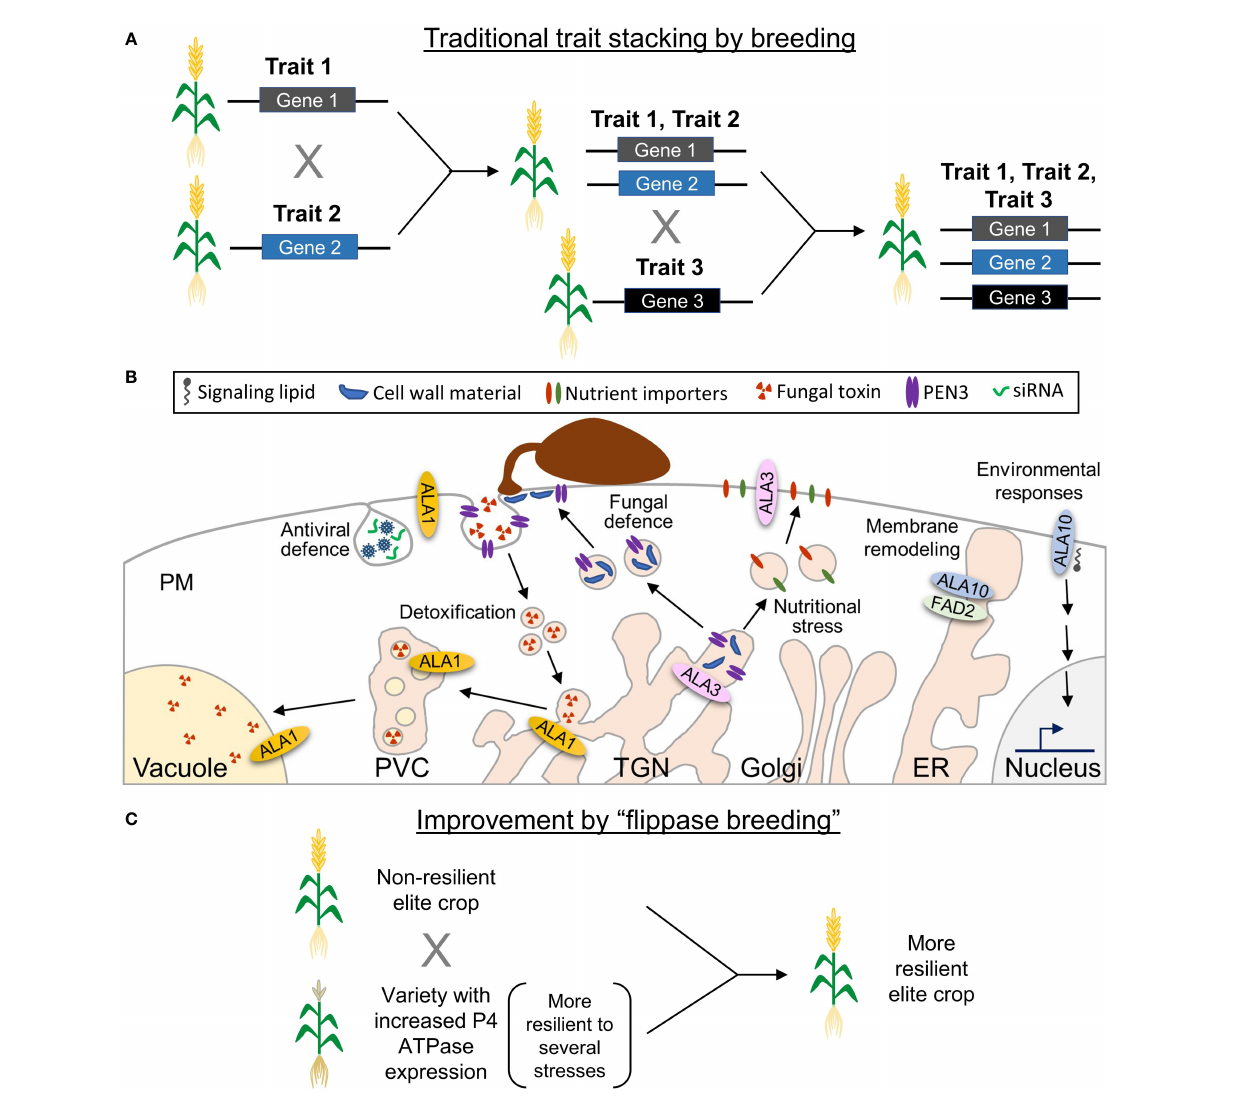
FIGURE 1 Potential of lipid fl ippases as biotechnological targets for crop improvement. (A) In traditional breeding strategies, generation of plants with several desirable traits is accomplished by successively crossing plants that contain each of the individual traits, which makes the process